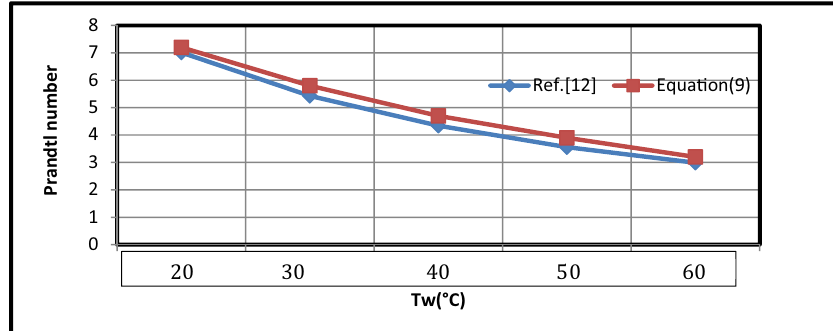
Figure 10: Prandtl number of water with temperature.